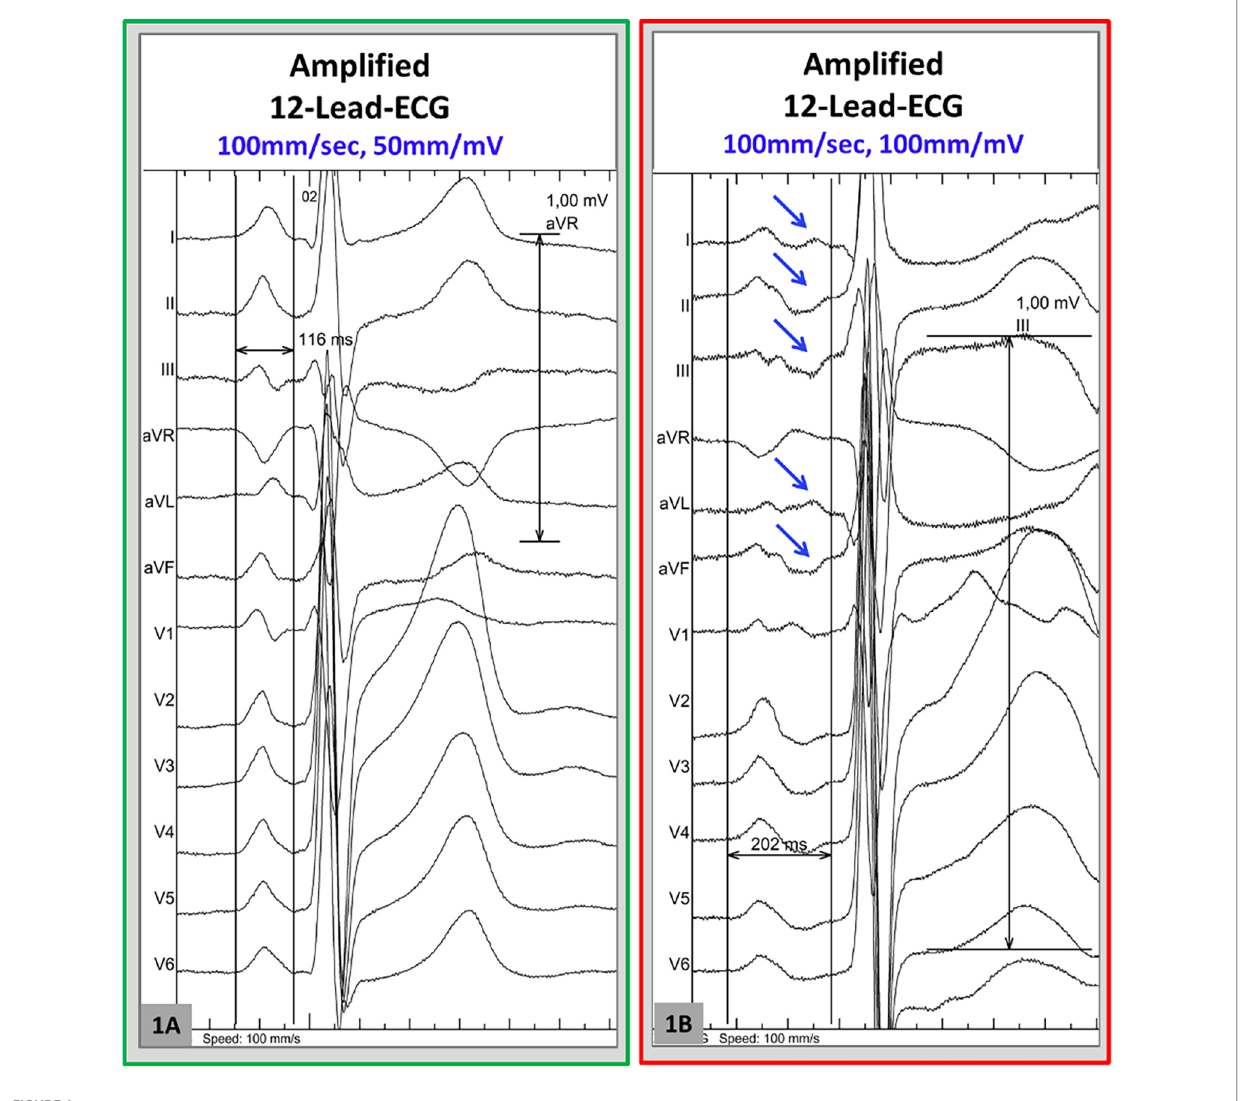
FIGURE 1 Examples onf ampli fi ed-P wave (APW) measurement. 12-lead-ECG in sinus rhythm was recorded digitally at 1,000 Hz sample rate and ampli fi ed to 100 – 200 mm/s sweep speed and 50 – 100 mm/mV, in order to allow visualization of low voltage portions of the p -wave. ( A ) This illustrates an example of